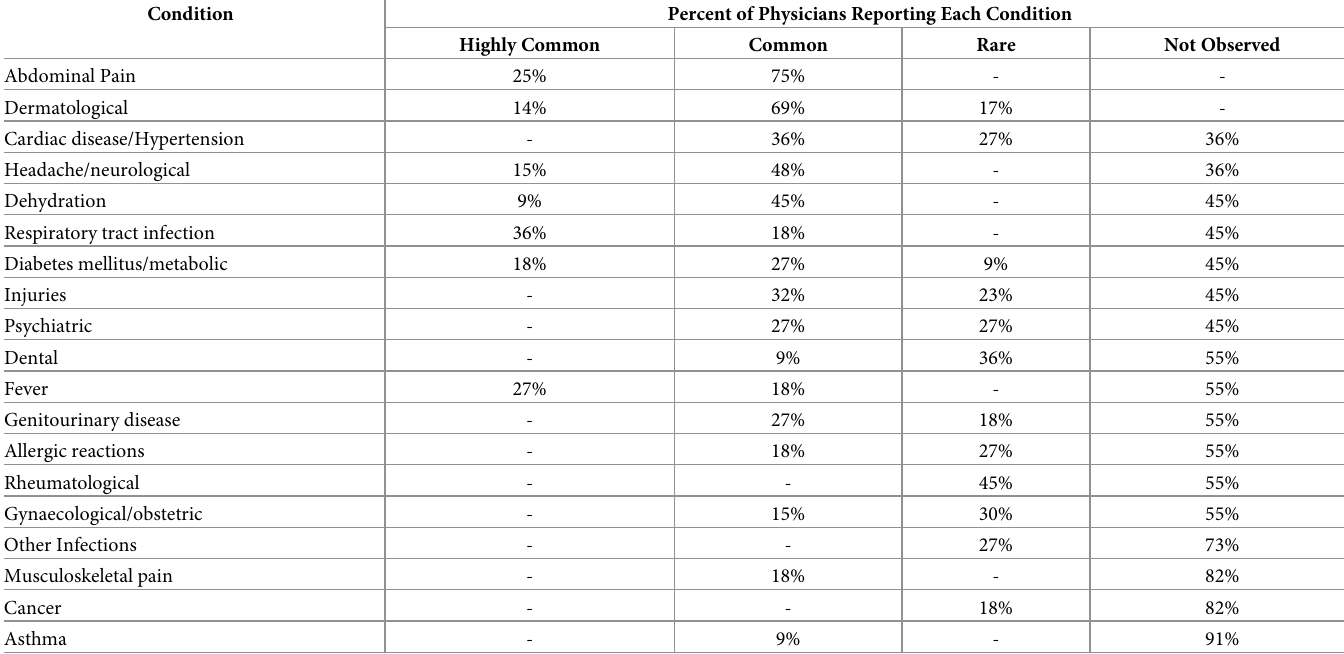
Table 2. Frequency of conditions presented by asylum seekers and refugees as reported by volunteer providers (n = 75).